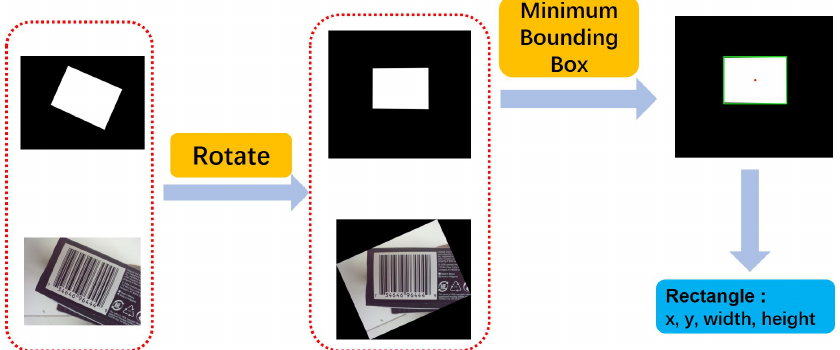
Figure 4. Data processing for the region estimation network: 1D barcode color image and the mask image rotated at the same angle θ . We used the rotated 1D barcode color image as training data. The rotated mask image generates a minimum bounding box where the position and range information (four values in the blue box) are the